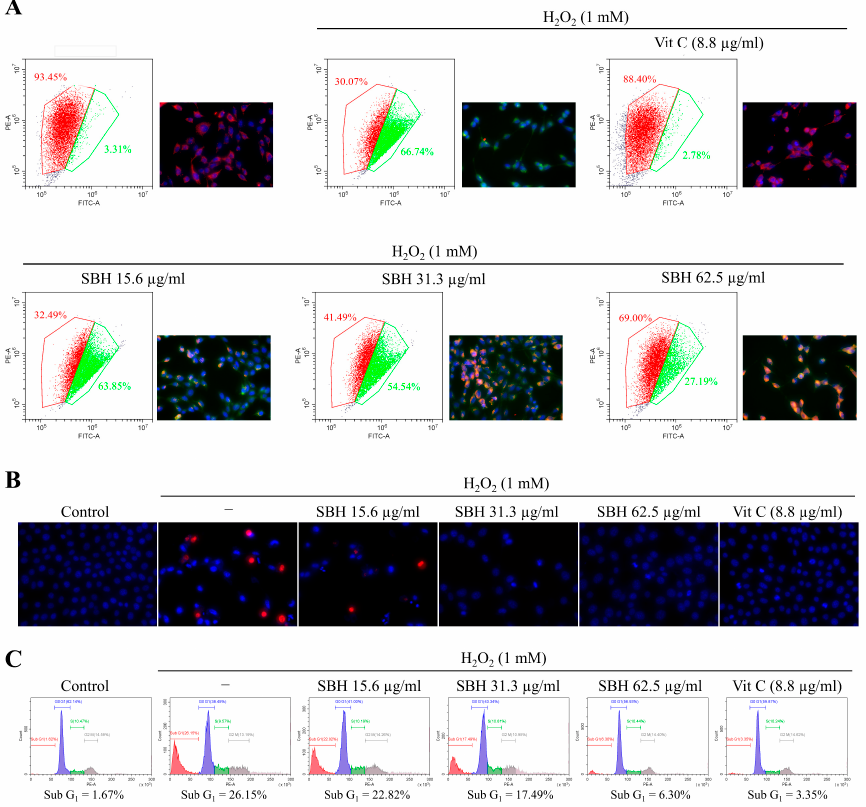
Figure 4. Effects of SBH in reducing mitochondrial depolarization and anti-apoptotic effects in H 2 O 2 -induced Vero cells. ( A ) Effects of SBH against H 2 O 2 -induced mitochondrial depolarization; ( B ) Effects of SBH against H 2 O 2 -induced apoptotic body formation; and ( C ) reduction of the apoptotic hyperdiploid cell population. Experiments were carried out in triplicate ( n = 3) to ensure